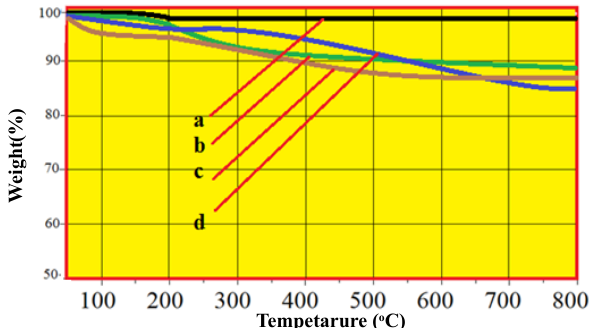
Fig. 4. TGA curve for(a) bare magnetite, (b) magnetite-citric acid, (c) Fig. 4 magnetite-salicylic acid and (d)